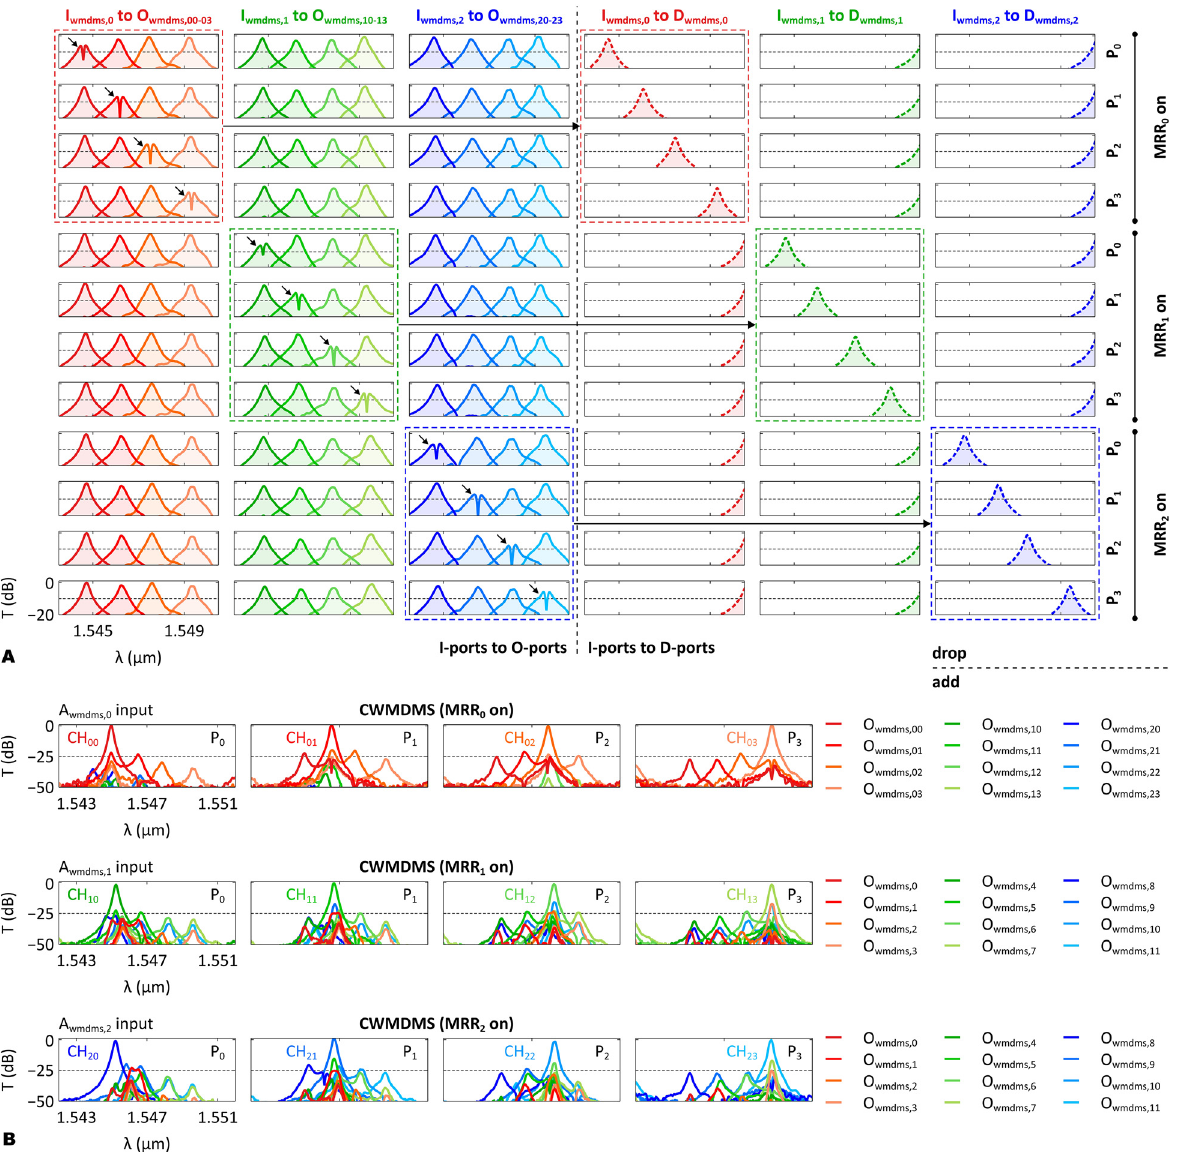
Figure 8: Add-drop operation results for direct-access wavelength/mode-division multiplexing switches (MDMSs). (A) The measured transmittance spectra at output ports (left panel) and dropping ports (right panel) as light was launched from input ports while different electric power ( P 0 – 3 ) was applied on MRR 0 – 2 . The dashed boxes and arrows highlight the dropped wavelength/mode-hybrid carriers. (B) The measured transmittance spectra at output ports as light was launched from adding ports and different electric power ( P 0 – 3 ) was applied on MRR 0 – 2 . CWMDMS, cascaded wavelength/mode-division multiplexing switch; MRR, micro-ring